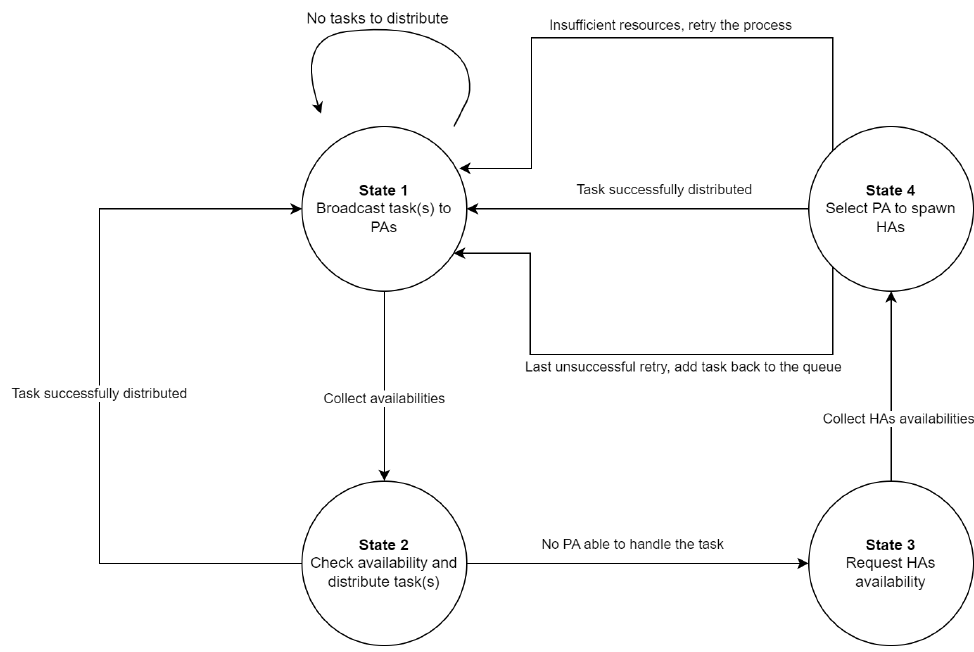
Figure 2. The states of the dispatcher